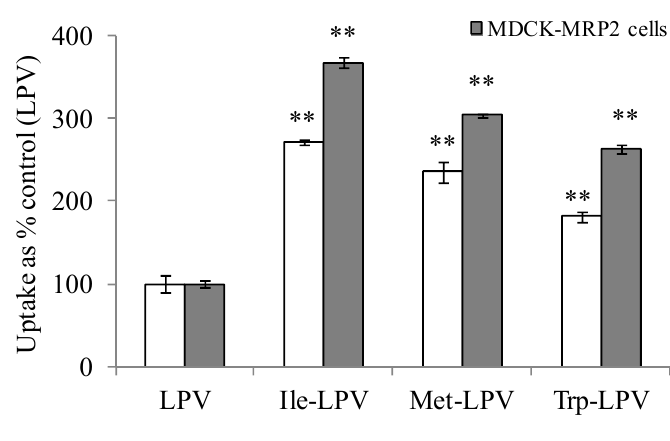
Figure 4. Cellular uptake of unlabelled LPV and prodrugs in MDCK-MDR1 (empty bars) and MDCK-MRP2 (filled bars) cells in DPBS (pH 7.4) at 37 °C. Each data point is expressed as mean ± standard deviation (n = 3). Uptake is expressed as percentage